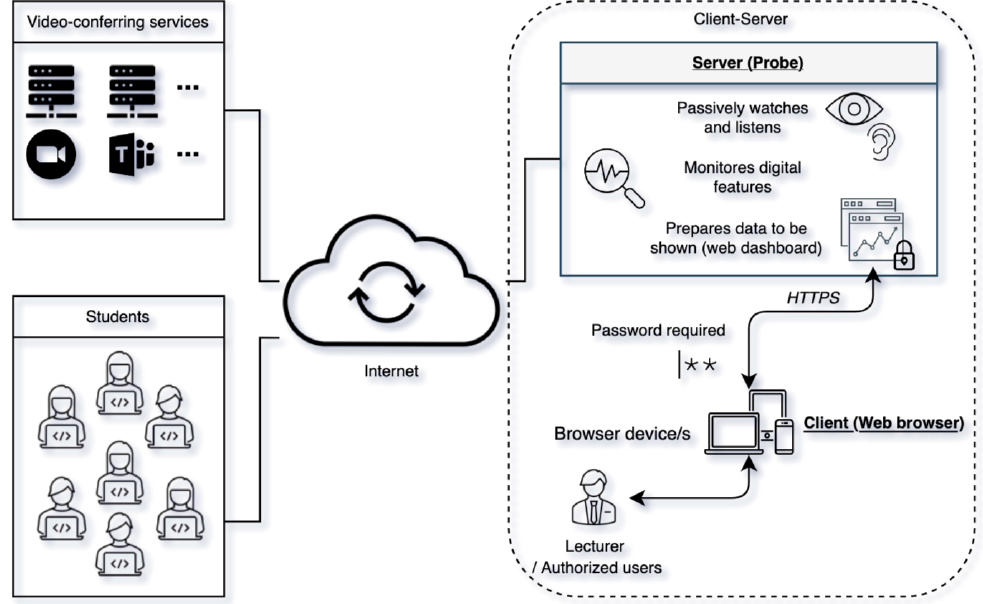
Figure 2. System prototype conceptualization, components and